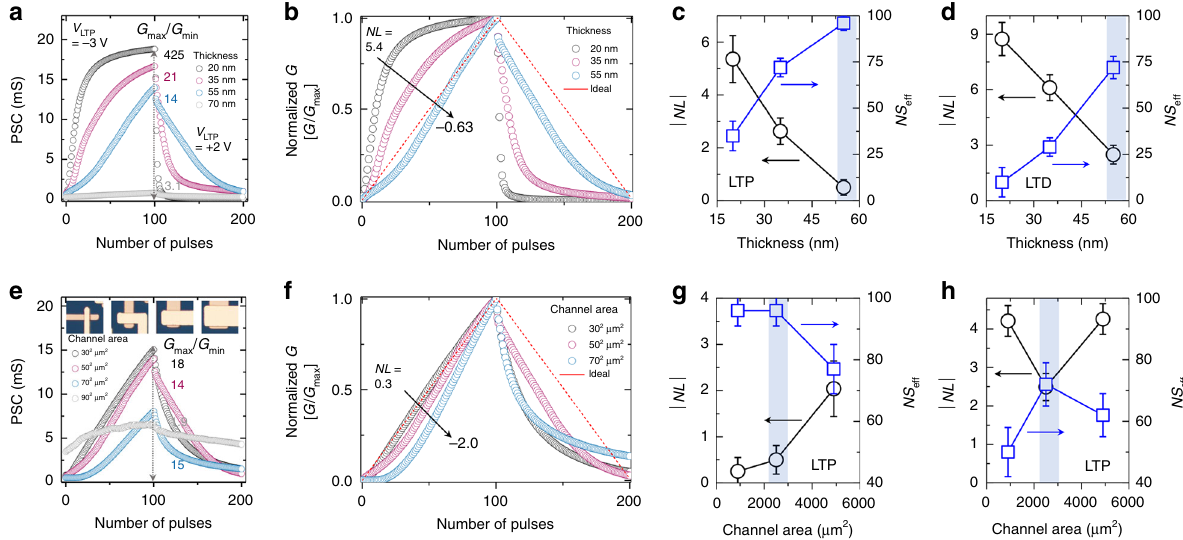
Fig. 3 Optimization of vertical synaptic device geometry. a LTP/D characteristics of thickness-controlled vertical crossbar synaptic devices under application of 100/100 potentiation/depression pulses ( V WC pulses with amplitudes of − 3 V/ + 2 V). Devices had P3HT channels with thicknesses of 20, 35, 50, and 70 nm. b , Normalized LTP/D curves of thickness-controlled synaptic devices. c Plots of |NL| and NS eff as functions of thickness of P3HT channel in LTP region and (d) LTD region. e LTP/D characteristics of synaptic devices with various areas of line cross-point. Channel area ( A ch ) was controlled to 30 × 30, 50 × 50, 70 × 70, and 90 × 90 μ m 2 as shown in the inset. f Normalized LTP/D curves of area-controlled synaptic devices. Plots of |NL | and NS eff as functions of area of line cross-point in g LTP and h LTD region. The average |NL|and NS eff are obtained from fi ve devices prepared independently, and the error bars represents the standard deviation of the